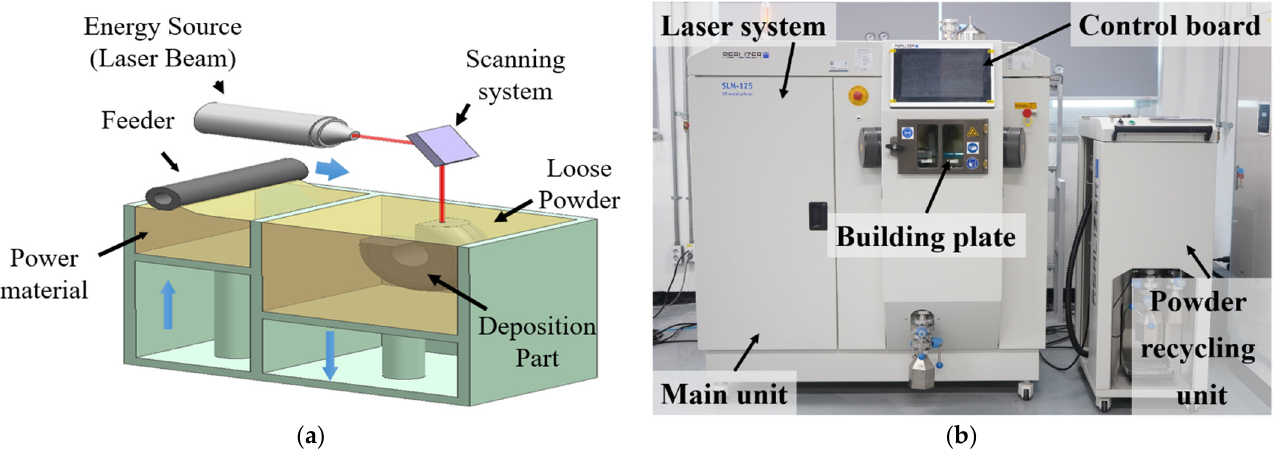
Figure 2. Conceptual diagram and experimental set-up of PBF process: ( a ) conceptual diagram of PBF process and ( b ) experimental set-up of PBF process.